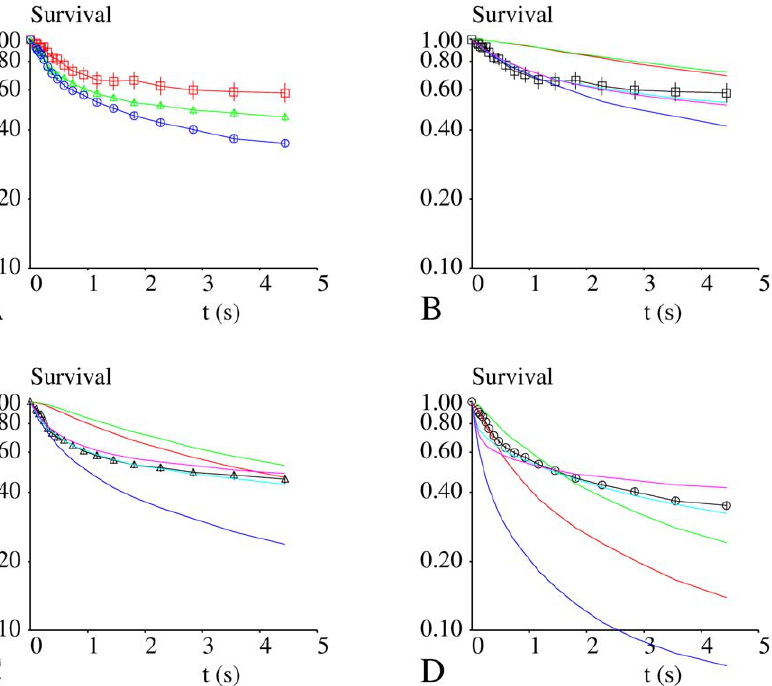
Figure 4. Lifetime of binding events recorded on surfaces coated with divalent ICAM-1. The figure shows the survival curves of binding events recorded between surfaces coated with low densities of Fc(ICAM-1) 2 molecules and microspheres coated with anti-ICAM-1 antibodies. Fig. 4A : all survival curves corrected for non specific arrests. Squares: wall shear rate 10.3 s 2 1 , microsphere velocity 12.5 m m/s, 122 binding events recorded. Force on bond is 8.80 pN. Triangles: wall shear rate 18.5 s 2 1 , microsphere velocity 22.5 m m/s, 1009 binding events recorded. Force on bond is 15.84 pN. Circles: wall shear rate 30.9 s 2 1 , microsphere velocity 37.5 m m/s, 1939 binding events recorded. Force on bonds is 26.40 pN. Fig. 4B. Squares: experimental data, lowest wall shear rate: 10.3 s 2 1 . Theoretical curves are shown for the following conditions: two bonds at time zero, k r =0, force not shared (red) or shared (green) between bonds. One bond at time zero, k r =0, (blue), one bond at time zero, k r =0.3 s 2 1 , force not shared (cyan) or shared (purple) between bonds. Fig. 4.C . Triangles: experimental data, intermediate wall shear rate 18.5 s 2 1 . Theoretical curves are shown for the following conditons: Two bonds at time zero, k r =0, force not shared (red) or shared (green) between bonds. One bond at time zero, k r =0 (blue),. one bond at time zero, k r =1.1 s 2 1 , force not shared (cyan) or shared (purple) between bonds. Fig. 4D . Circles: experimental data, highest shear rate 30.9 s 2 1 . Theoretical curves are shown for the following conditions: Two bonds at time zero, k r =0, force not shared (red) or shared (green) between bonds. One bond at time zero, k r =0 (blue), one bond at time zero, k r =12 s 2 1 , force not shared, (cyan) or k r =6s 2 1 , force shared (purple) between bonds. Vertical bar length is twice the standard error. Fig. 3B and Table 1, this simple formula allowed a close fit with experimental values, since the mean square of relative difference (MSD) between fitted curves and experimental points was less than 0.0015. Interestingly, this formula also allowed a satisfactory fit of force-free detachment data (Fig. 5 and Table 1).